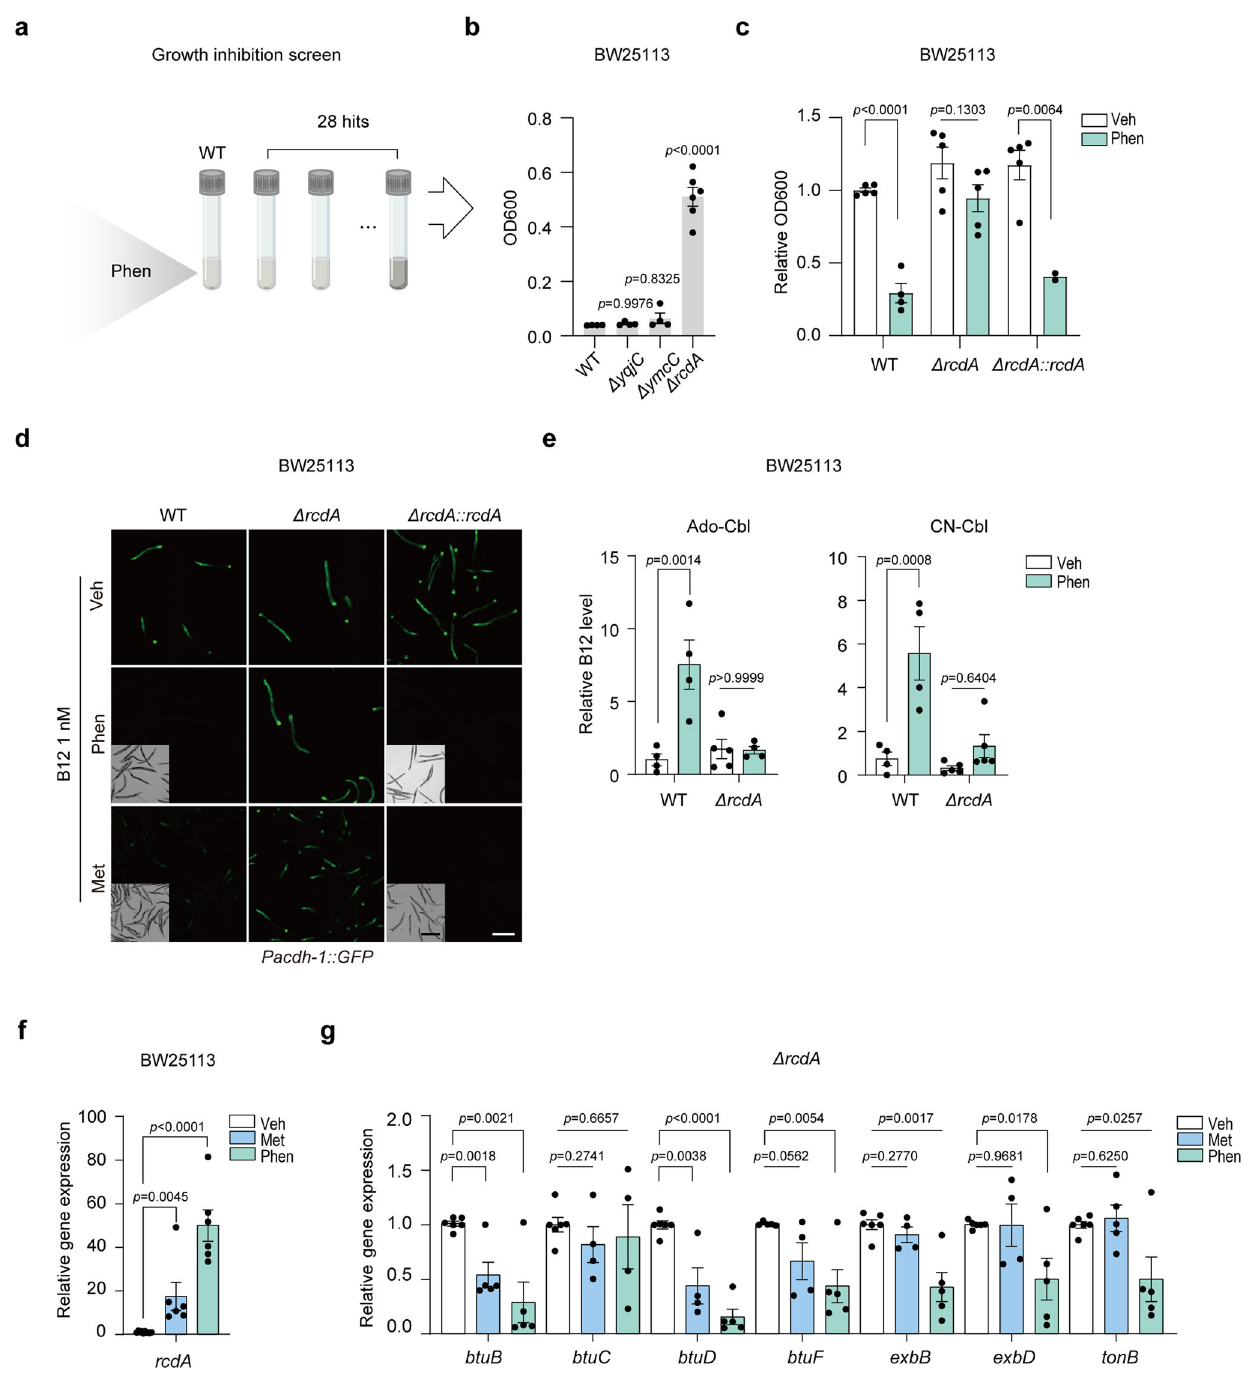
Fig. 4 Biguanides induce bacterial growth inhibition and B12 accumulation through RcdA. a Scheme of the growth inhibition screen. The growth statuses of 28 hits from the secondary screen after treatment with 5 mM phenformin were evaluated by optical density. b The outcomes of the growth inhibition screen. OD600 value measurement of WT, Δ yqjC, Δ ymcC , and Δ rcdA . N = 2 independent experiments containing 6 replicates. c Growth of WT, Δ rcdA , and Δ rcdA::rcdA cells treated with 4 mM phenformin. N = 2 independent experiments containing 2 – 5 replicates. d Representative images of Pacdh-1::GFP worms fed WT, Δ rcdA , and Δ rcdA::rcdA pretreated with 4 mM phenformin/200 mM metformin or not. N = 3 independent experiments containing at least 30 worms per group. Scale bar: 250 μ m ( fl uorescence images) and 500 μ m (bright fi eld images). e LC-MS/MS measurement of B12 levels in WT and Δ rcdA treated with 4 mM phenformin or untreated. N = 3 independent experiments containing 4 – 5 replicates. f Relative mRNA levels of rcdA with 200 mM metformin or 4 mM phenformin treatment. g Relative mRNA levels of genes involved in B12 transport in Δ rcdA with 200 mM metformin or 4 mM phenformin treatment. For ( f , g ), N = 2 independent experiments containing 4 – 6 replicates. The statistical signi fi cance values were determined by ordinary one-way ANOVA for ( b ) and ( e ) and multiple t tests for ( c ) and ( f , g ). Error bars denoted the S.E.M.